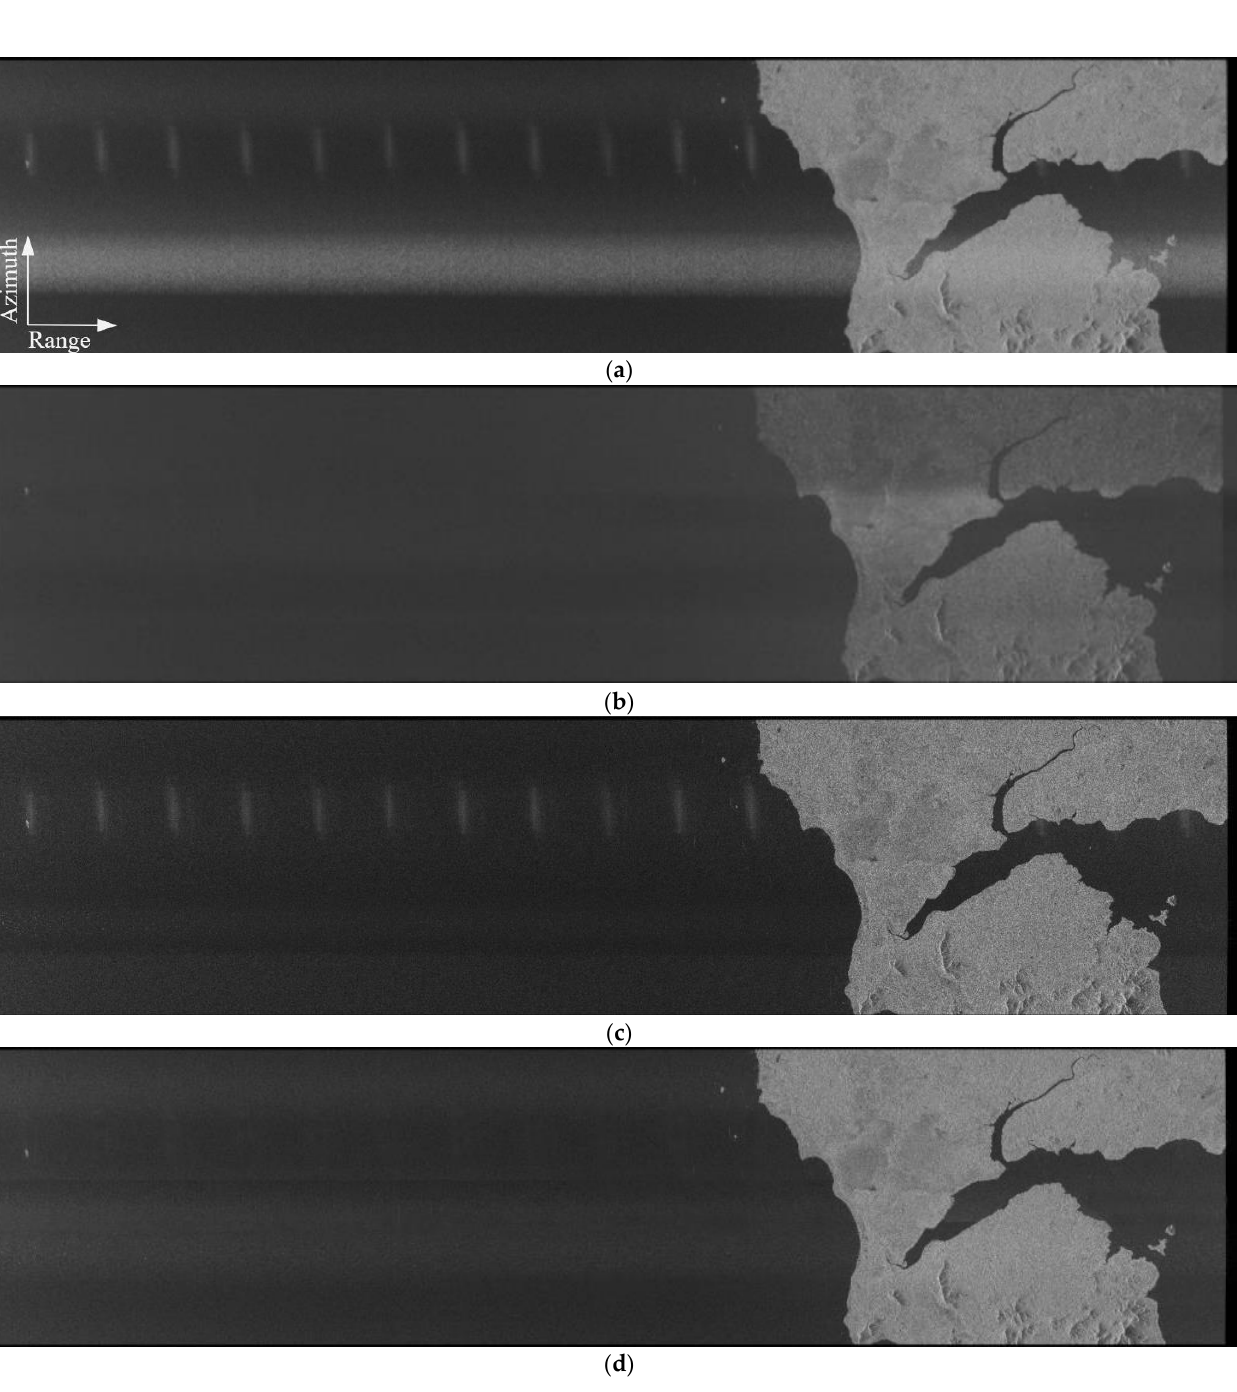
Figure 13. Experimental results for scene 1. ( a ) SAR SLC image without mitigation process. ( b ) Mit- igation result by FNF method. ( c ) Mitigation result by ESP method. ( d ) Mitigation result by pro- posed